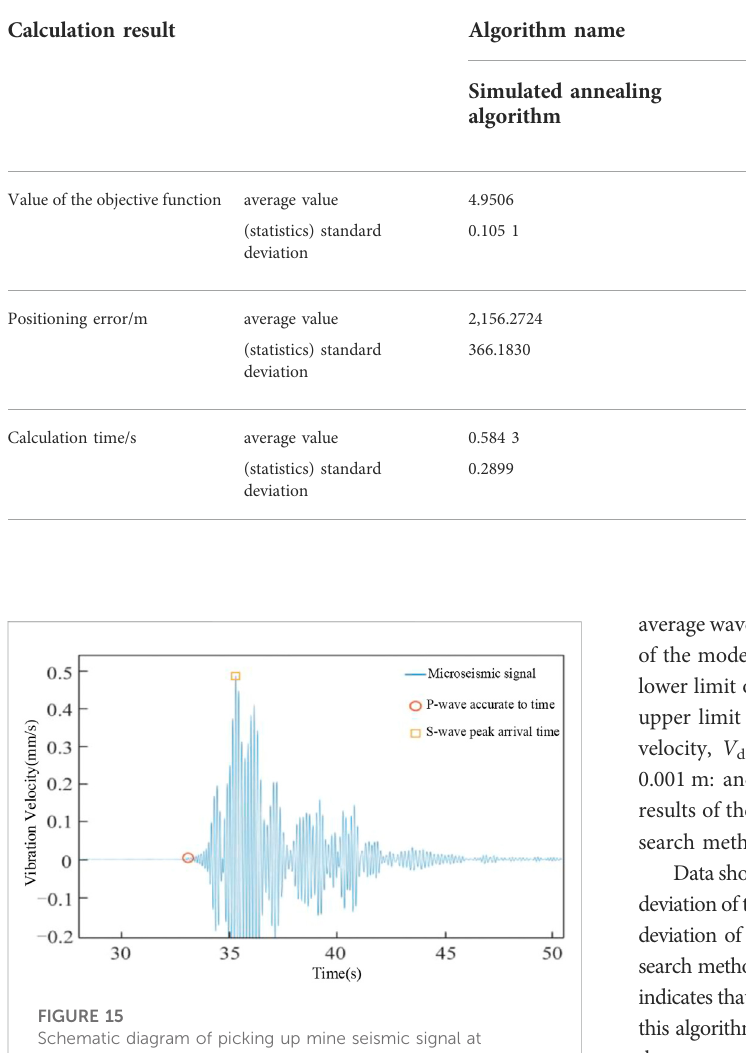
TABLE 6 Comparison of location effect of three algorithms.